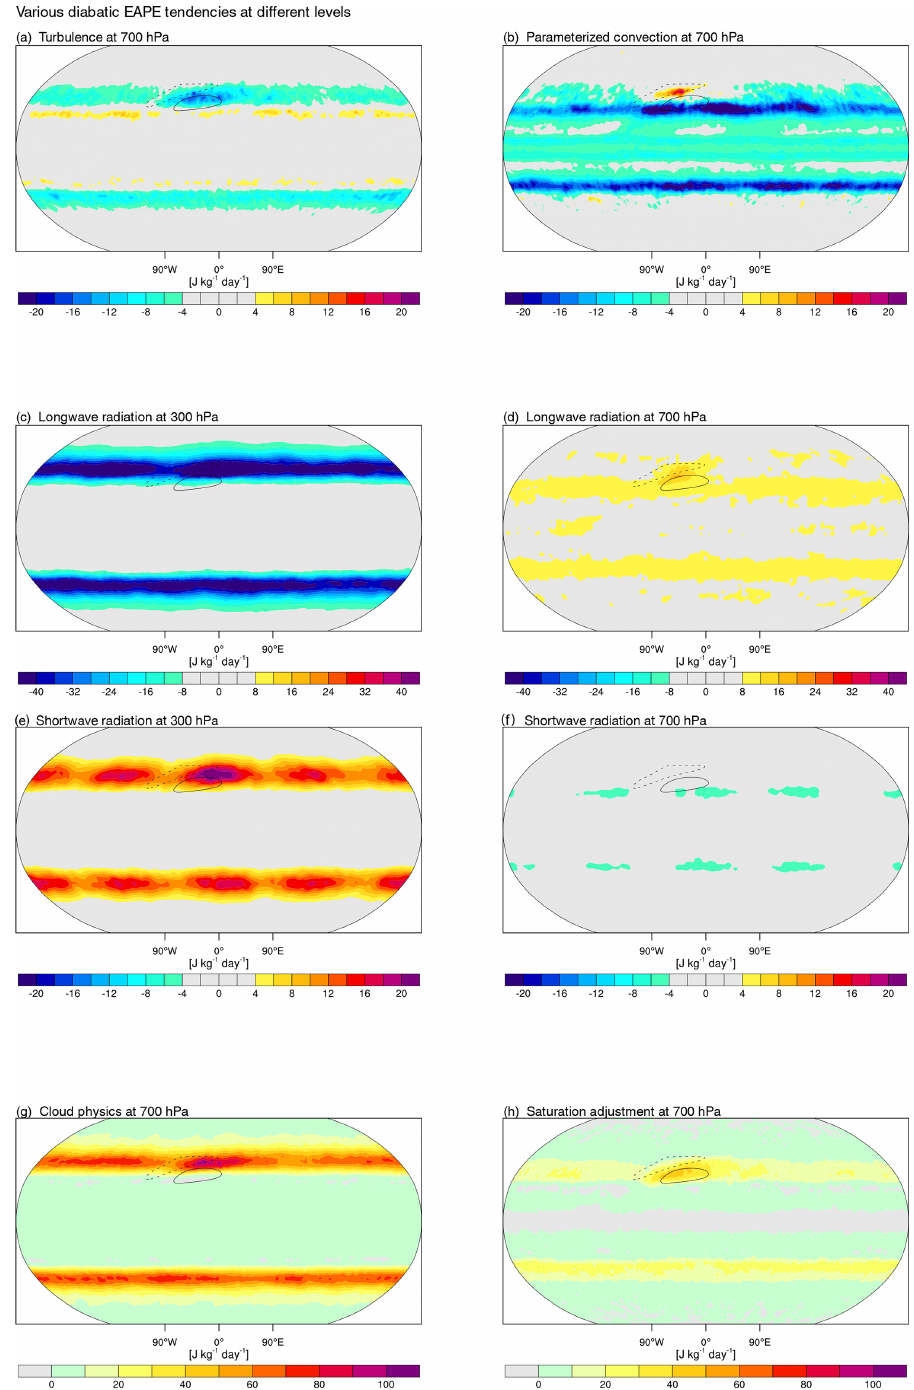
Figure C1. Diabatic EAPE tendencies for different processes on different selected levels for the control simulation. Note the different scaling for each panel. EAPE tendencies due to (a) turbulence and (b) parameterized convection at 700hPa, longwave radiation at (c) 300 and (d) 700hPa, shortwave radiation (e) at 300 and (f) 700hPa (note reduced scaling by a factor of 2 compared to longwave radiation), (g) cloud physics, and (h) saturation adjustment at 700hPa. Units are Jkg − 1 d − 1